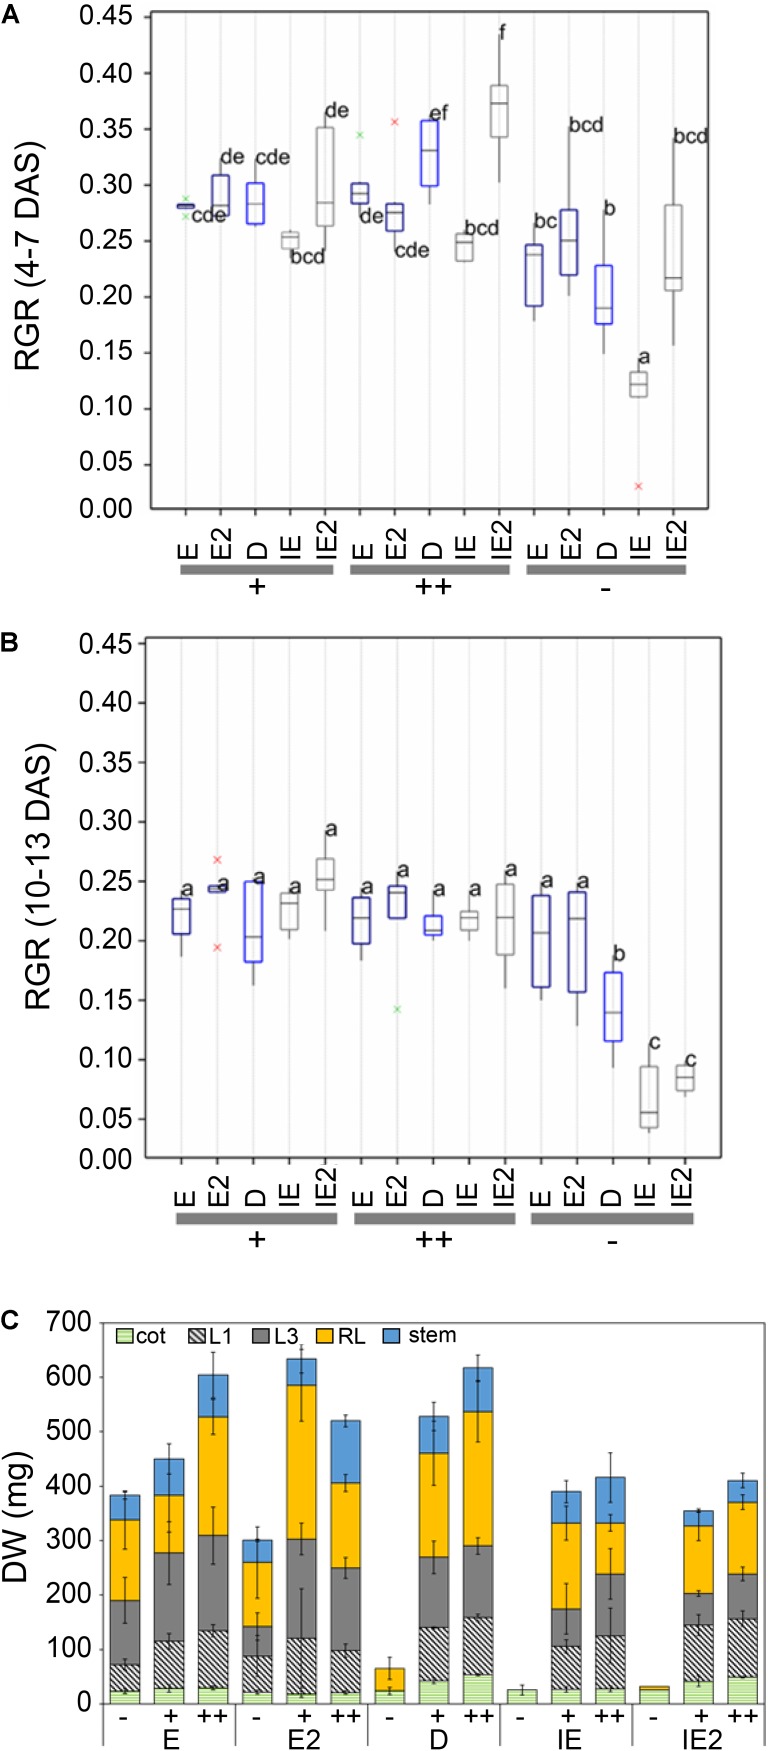
(A) B-dependent relative growth rates (RGR) based on the measurement of the leaf surface area (border length) of different B-efficient (E = CR2267, E2 = CR2280), moderate (Darmor; D), or inefficient (IE = CR2262, IE2 = CR3153) B. napus cultivars recorded in the LemnaTec facility at early (4–7 DAS) (A), or later (10–13 DAS) (B) growth stages. Different letters indicate significantly different RGRs. Red and green crosses mark outliers outside the 5 and 2.5% range of the standard deviation of the value distribution, respectively. (C) Measurements of aboveground physical growth parameters of B. napus plants grown in the automated phenotyping facility. DW per plant part [cotyledons, leaf 1 (L1), leaf 3 (L3), remaining leaves (RL), stems] of indicated B. napus cultivars grown under B-deficient (–), B-sufficient (+), or B-surplus (++) conditions. DW values are means ± SD from n = 8 plants.